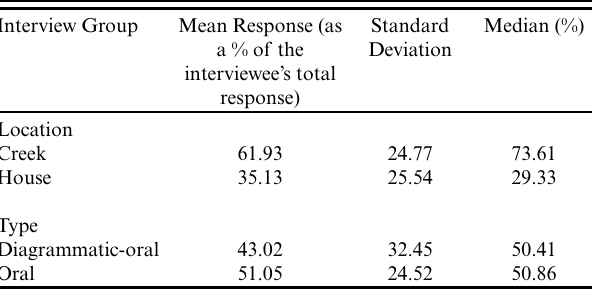
Table 4 . Mean and median percentage of the interview transcript coded as a specific response, as elicited using the different interview